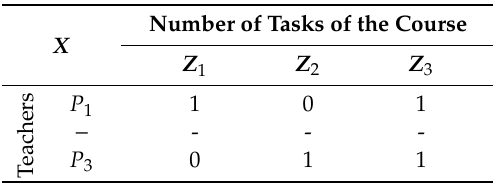
Table 4. A permissible teacher allocation, X , in the case of the absence of teacher P 2 . Number of Tasks of the Course X Z 1 Z 2 Z 3 s P 1 1 0 1 e r − - - - h a c P 3 0 1 T e